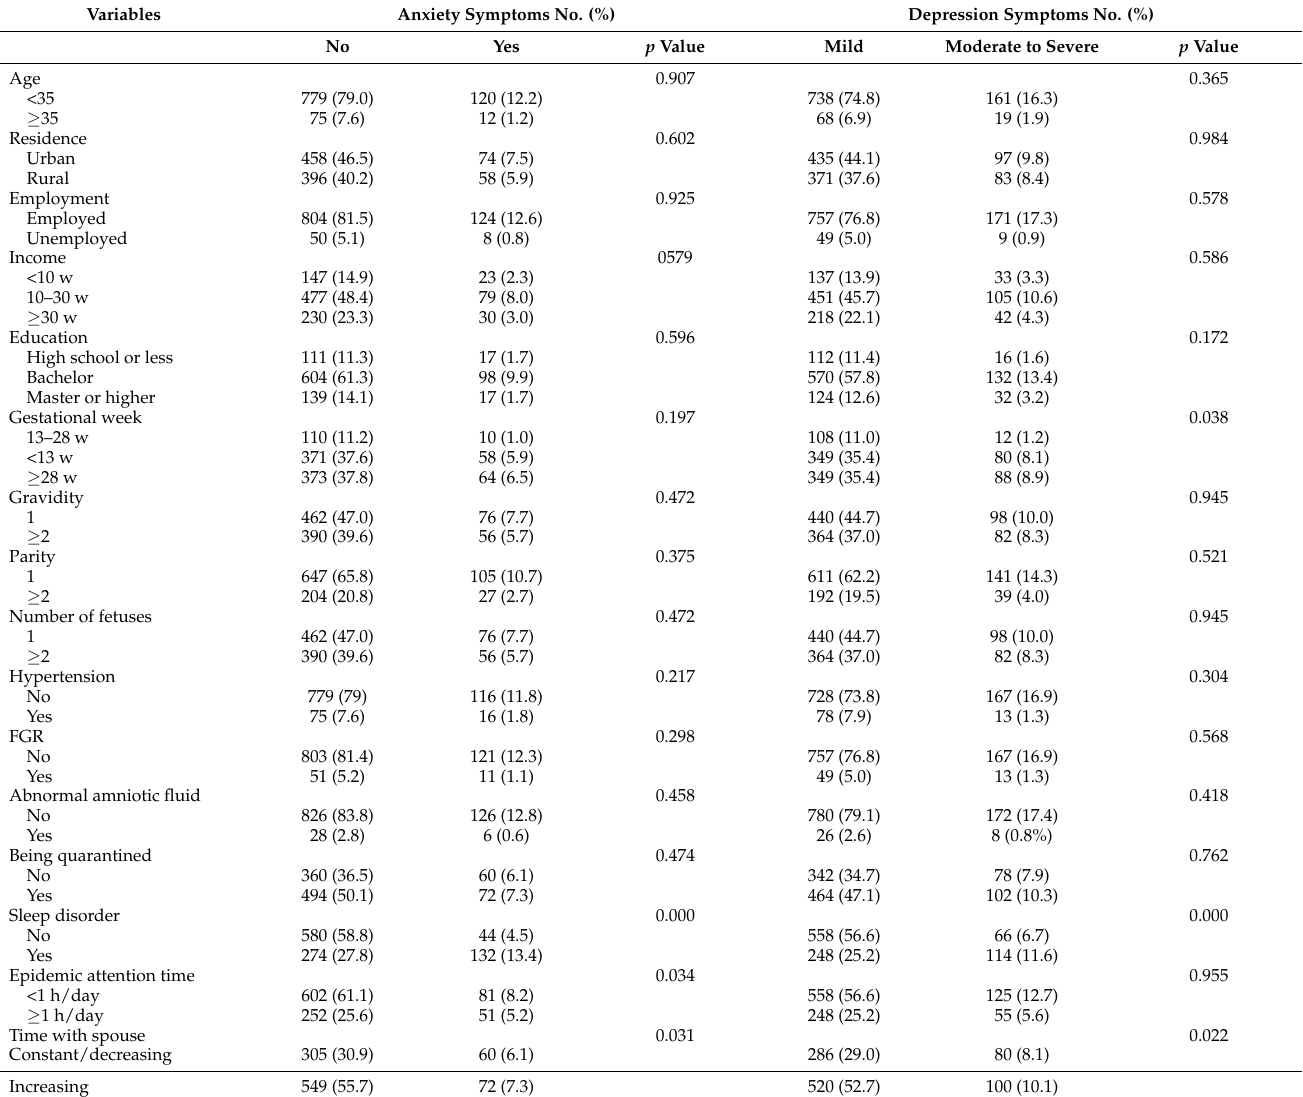
Table 2. Risk factors for the psychological status of pregnant women during the COVID-19